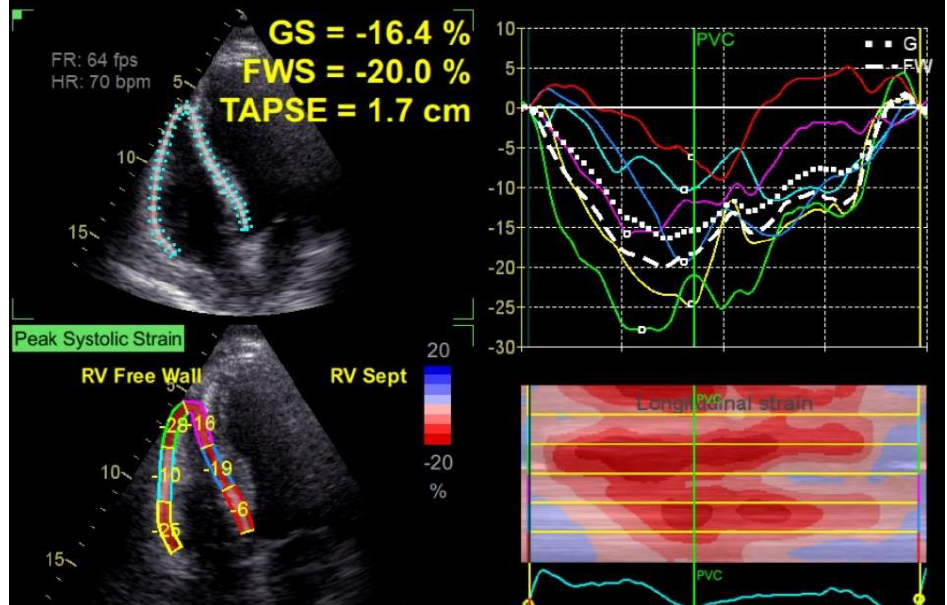
Figure 1. Calculation method of RV global longitudinal strain (GS) and free wall strain (FWS) using dedicated software.